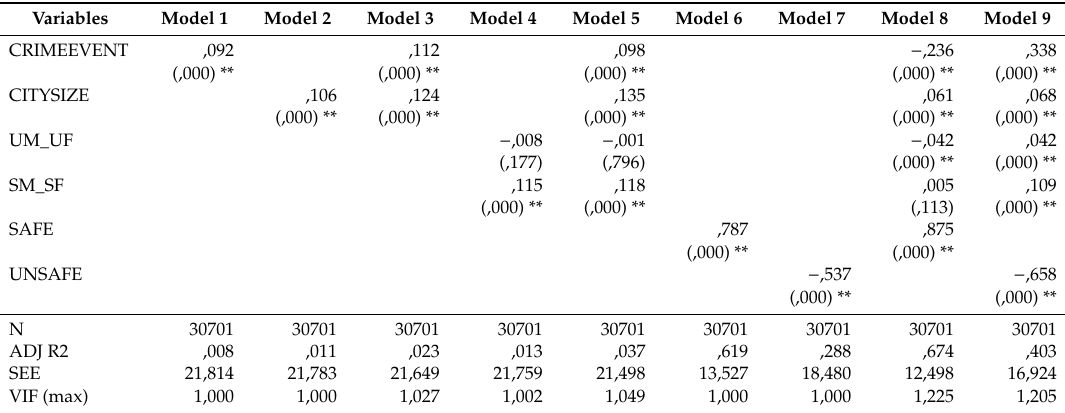
Table 3. Ordinary least squares (OLS) regression results in determining the overall perception of